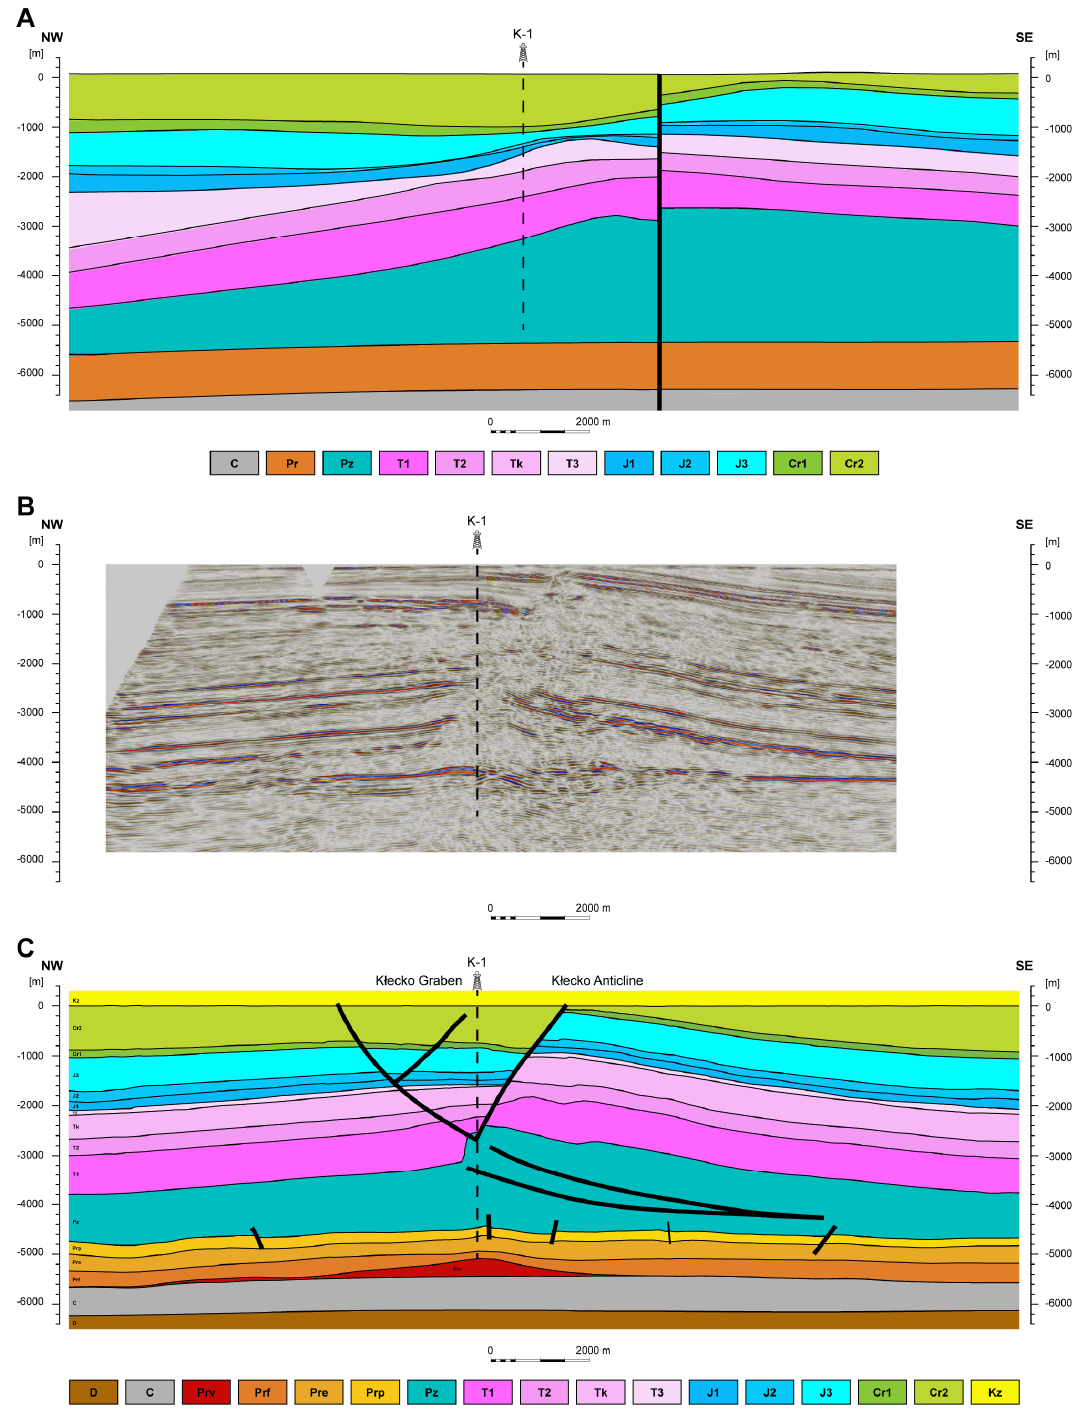
Figure 9. Structural interpretation of the K ł ecko Anticline ( A ) structural model SMV1 along seismic line 1; ( B ) seismic line 1 perpendicular to the anticline axis; ( C ) structural model in the new variant